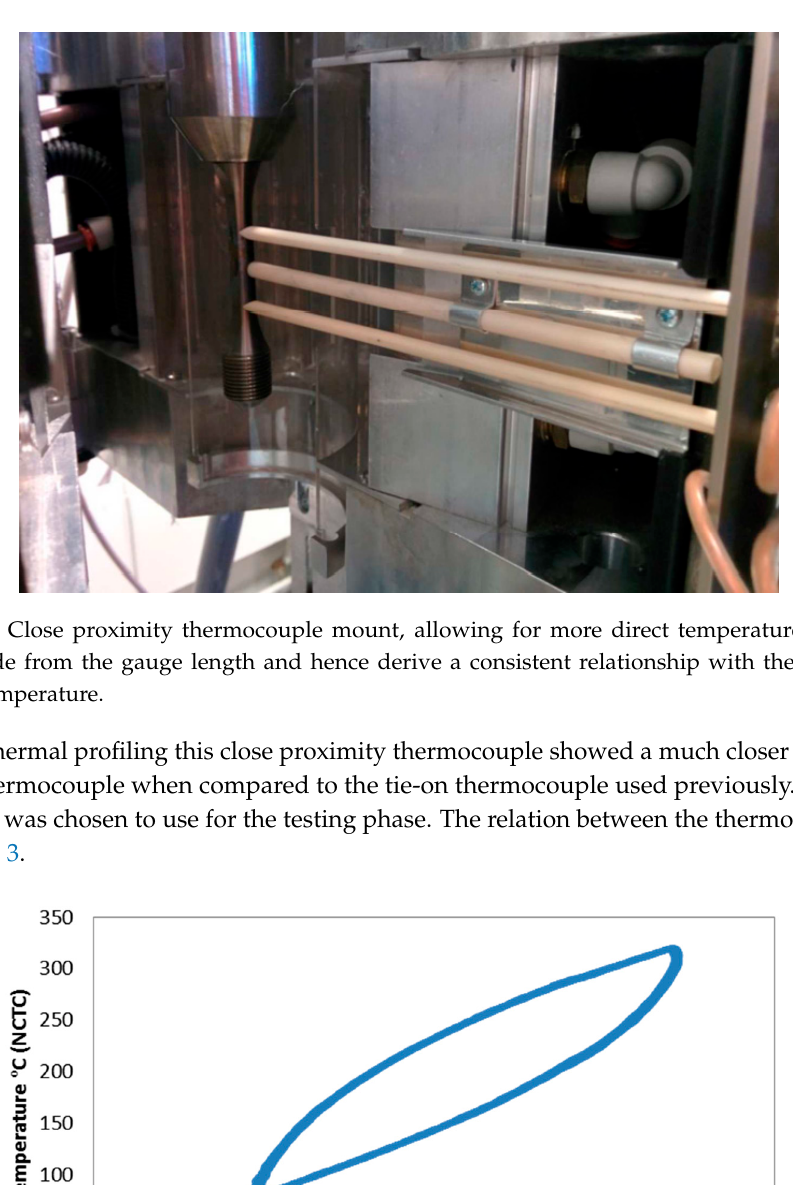
Figure 2. Close proximity thermocouple mount, allowing for more direct temperature readings to be made from the gauge length and hence derive a consistent relationship with the specimen surface temperature.